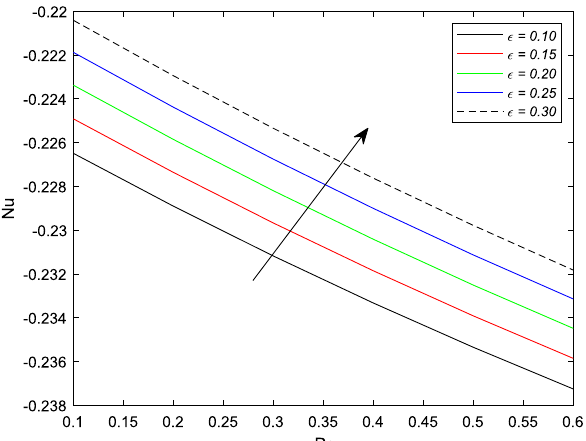
Figure 17. Impact of thermal conductivity parameter ǫ and Prandtl number Pr on Sherwood number.